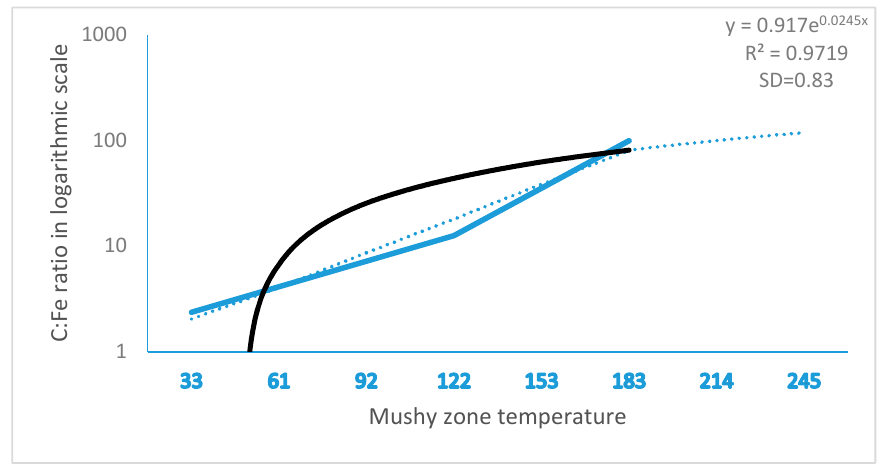
Figure 3. Correlation of C:Fe to mushy zone temperature.